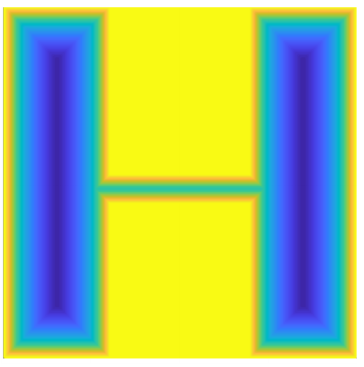
Figure 9. Potential energy